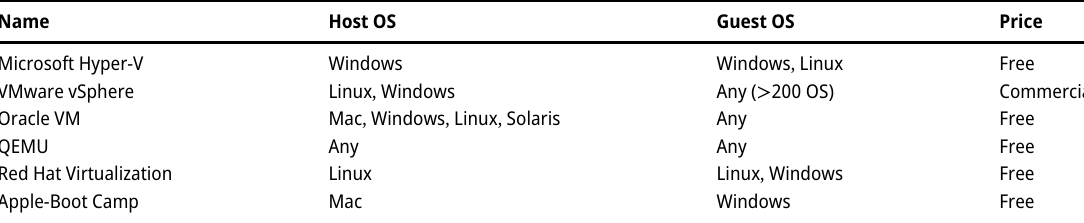
Table 1: Some virtual machines and their host and guest operating